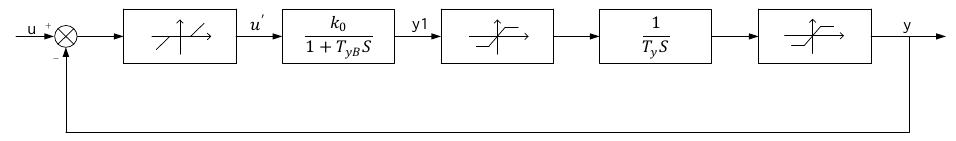
Figure 6. Structure of servo mechanism.